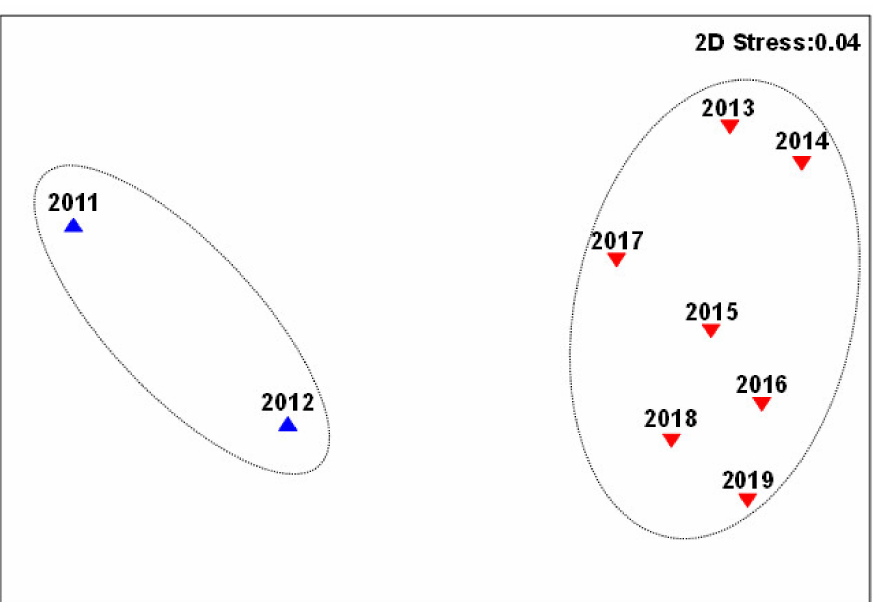
Figure 3. Non-Metric Multidimensional Scaling (NMDS) analysis of the fish assemblages in Lake Er- hai. Blue triangles represent the first group, red triangles represented the second group (Stress = 0.04).